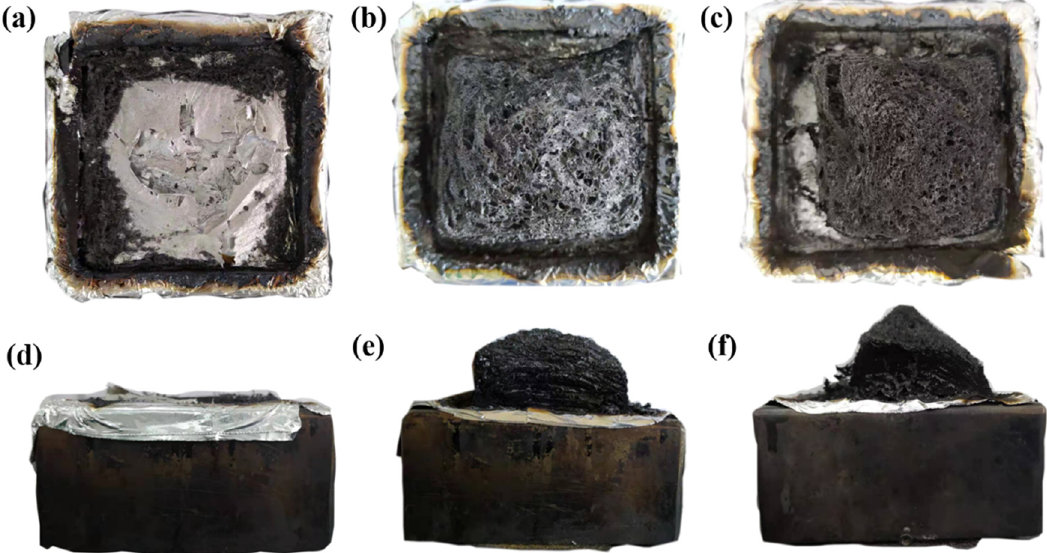
Figure A2: ( a – c ) Top view and ( d – f ) side view of EP, EP - 5 wt% DPCA, and EP - 5 wt%